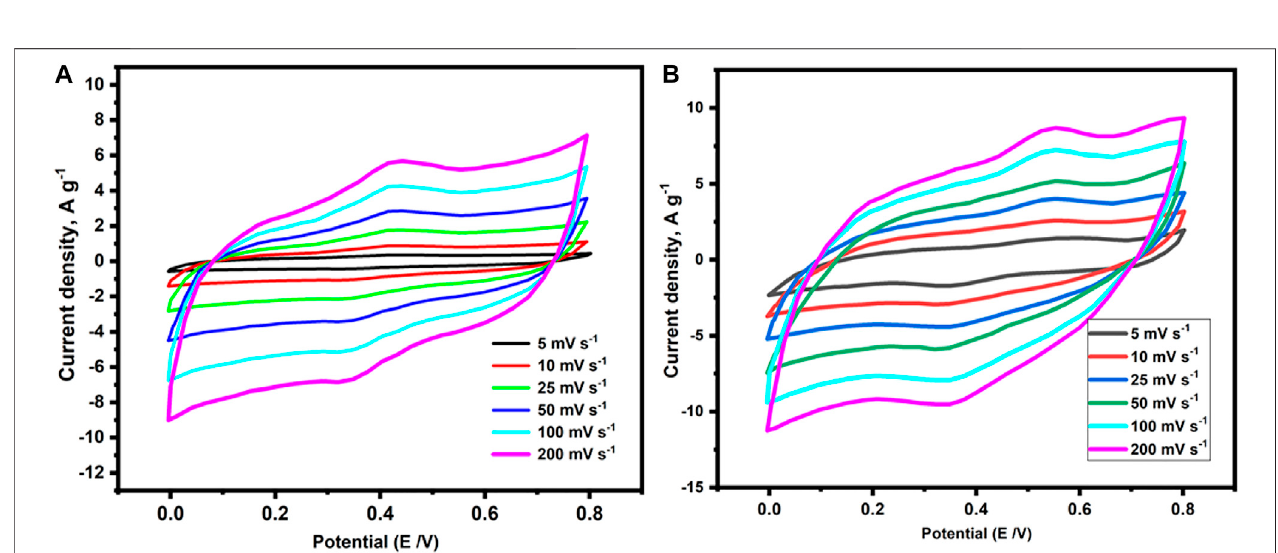
FIGURE 8 | Cyclic volumetric curves of (A) p-2CzPN and (B) p-4CzPN polymers attained at different scan rates.